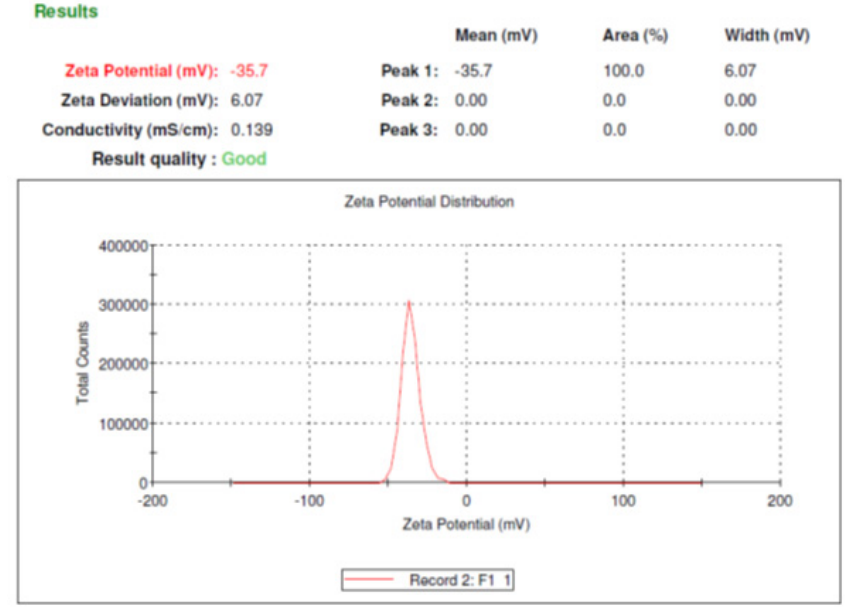
FIGURE 6 - Zeta potential report of optimized